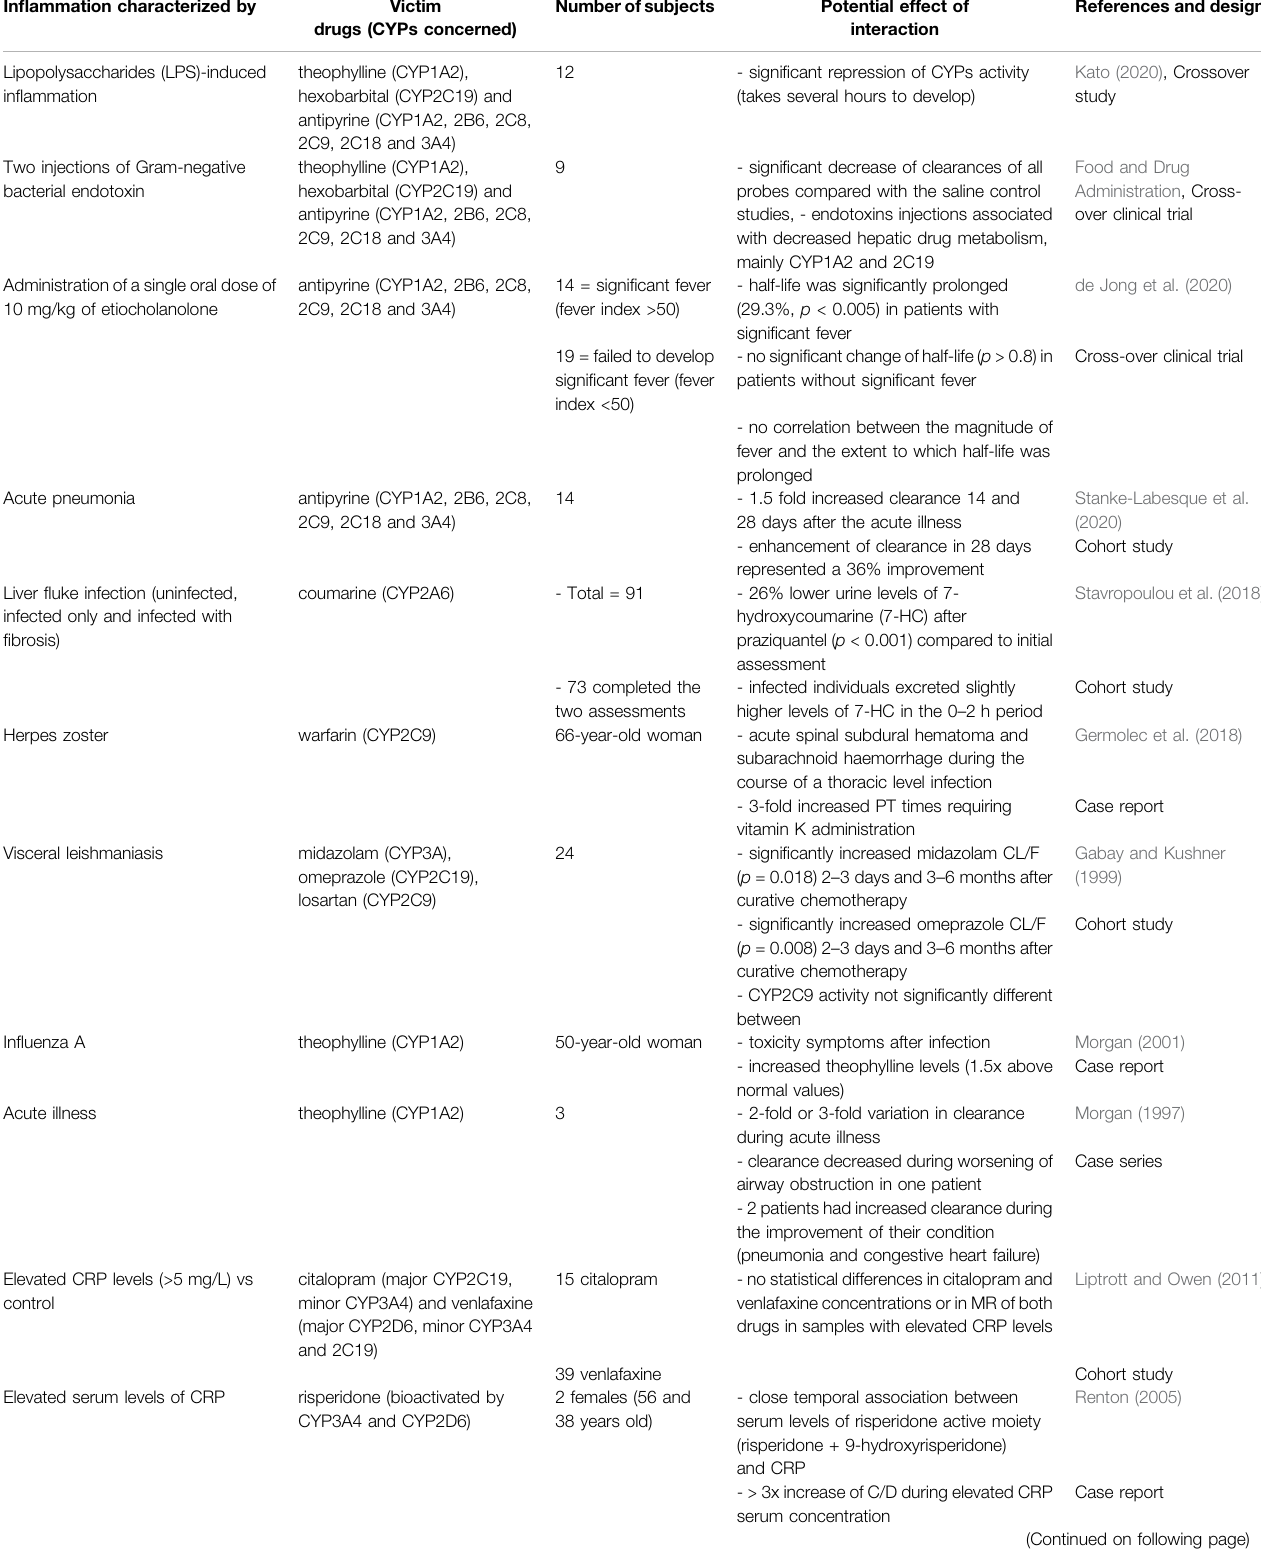
TABLE 2A | Impact of infection on CYP substrates, explained totally or partially by modulation of CYP activity. In fl ammation characterized